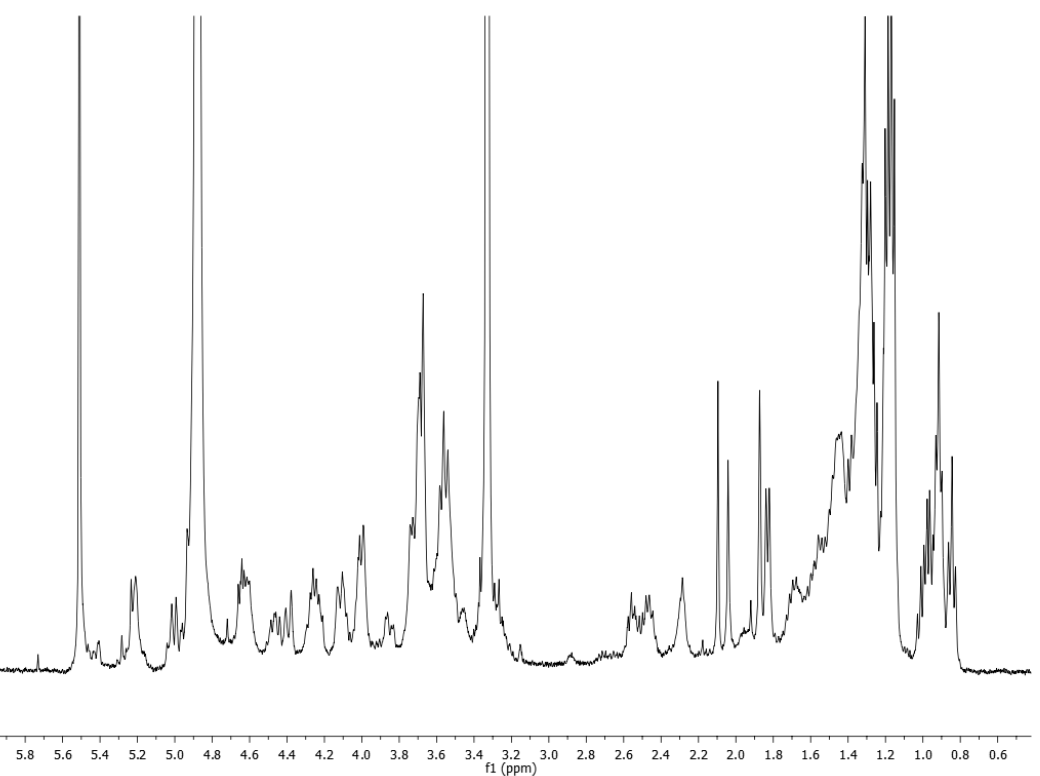
Figure 4. 1 H NMR spectrum of fraction F9.2 recorded at 400 MHz in CD 3 OD.